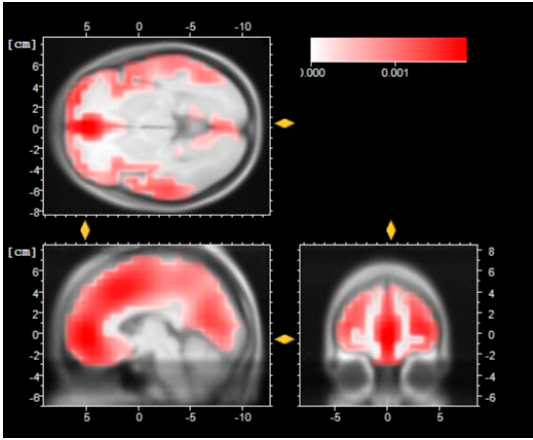
Figure 9. LORETA reconstruction of the N1 component after the Motor Imagery session.